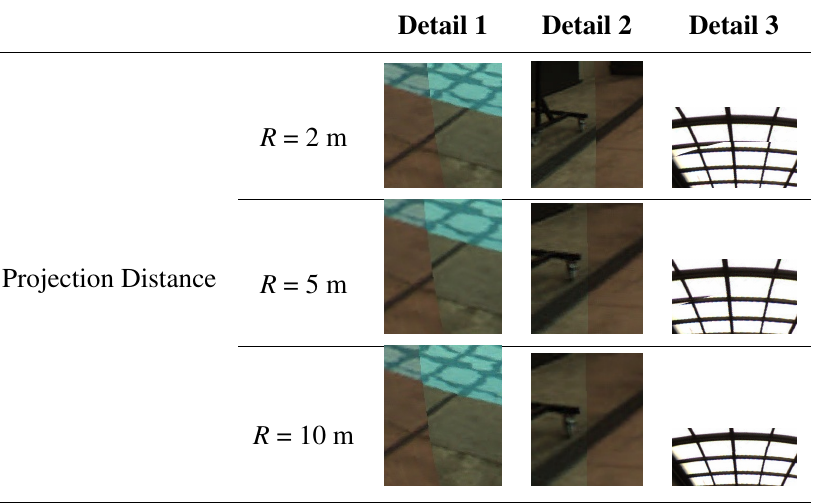
Table 2. Details of the same scene projected at different distances. The details are ordered by increasing distance to the